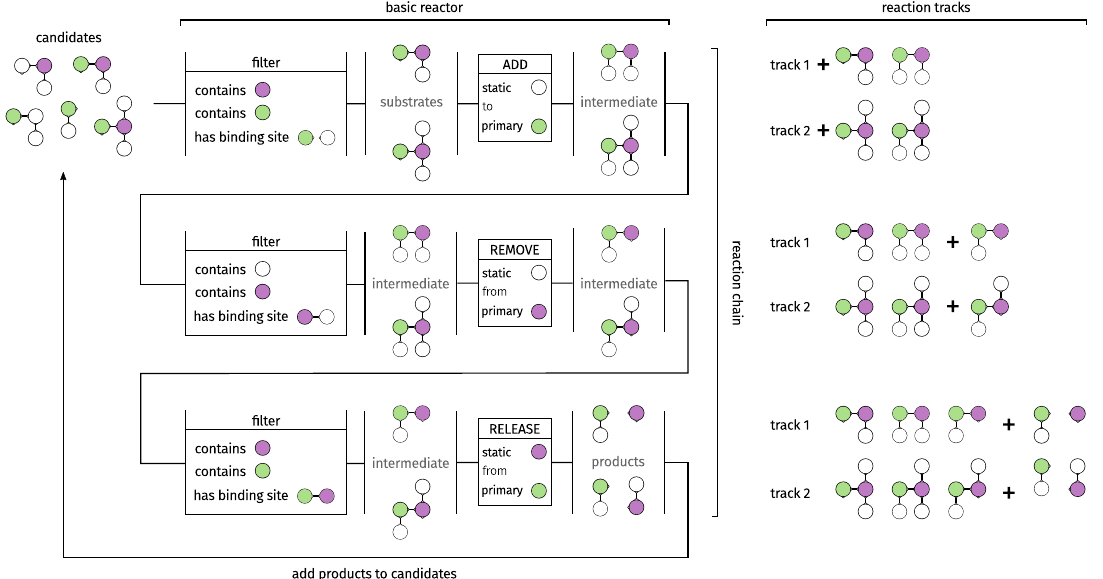
Fig. 9 Reaction network generation. Reactions can be speci fi ed by a description of the reaction process. Basic reactors are concatenated to chains that are processed during the reaction network generation. Additionally, conditions allow for further speci fi cation of the reaction